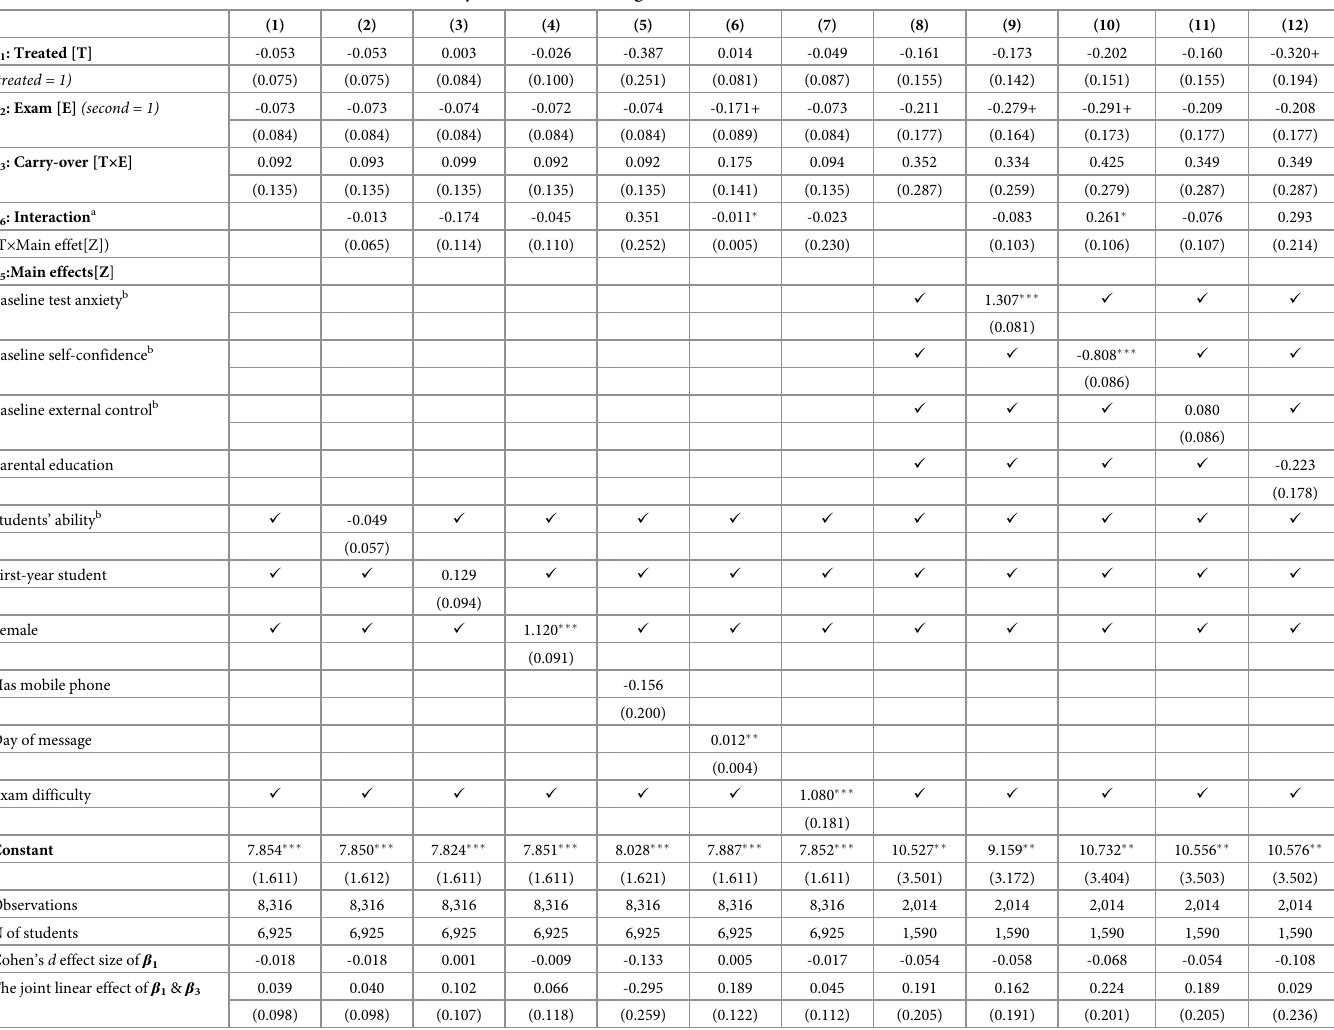
Table 5. Treatment effect on students’ endline test anxiety, unstandardized regression